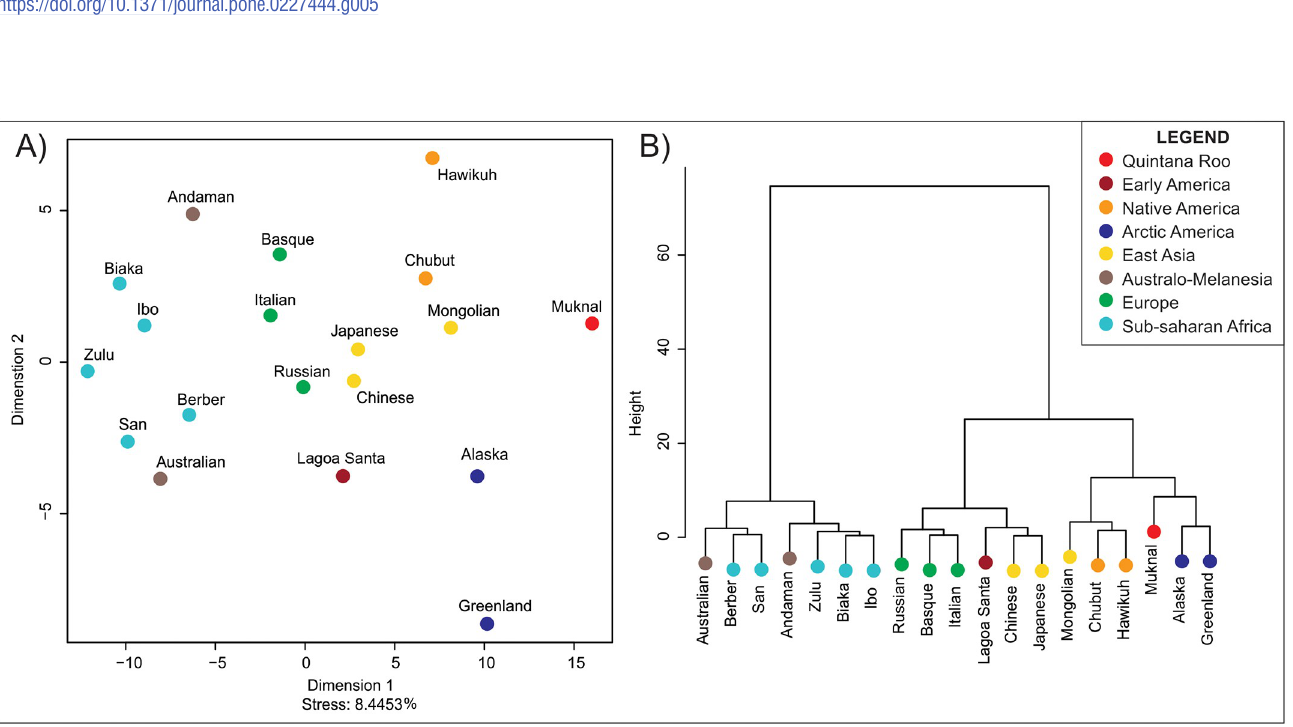
Fig 6. Morphological affinities between Muknal and reference series according to Mahalanobis distances of the first five Principal components. A) Multidimensional Scaling. B) Ward’s Cluster.